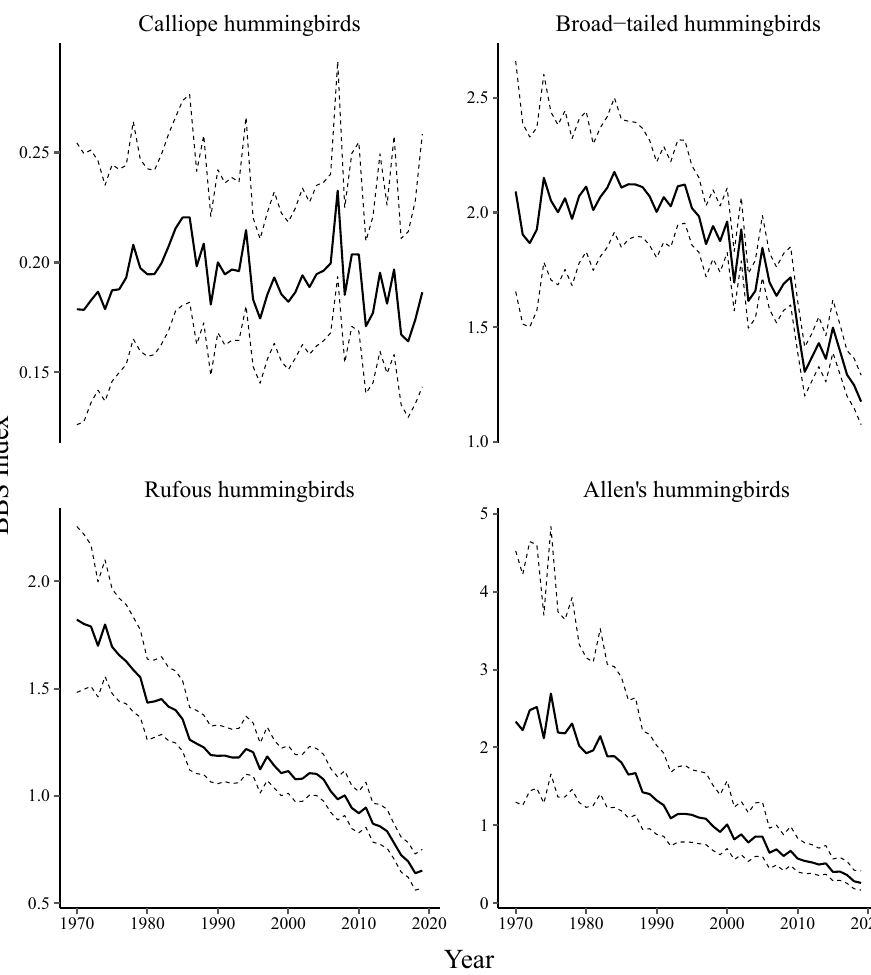
Figure 2. Breeding Bird Survey indices for North American hummingbirds in the Selasphorus genus from 1970 to 2019. The species of Selasphorus genus represented here are calliope hummingbirds ( Selasphorus calliope ), broad-tailed hummingbirds ( Selasphorus platycercus ), rufous hummingbirds ( Selasphorus rufus ), and Allen’s hummingbirds ( Selasphorus sasin ). Dashed lines represent upper and lower bounds of the 90%